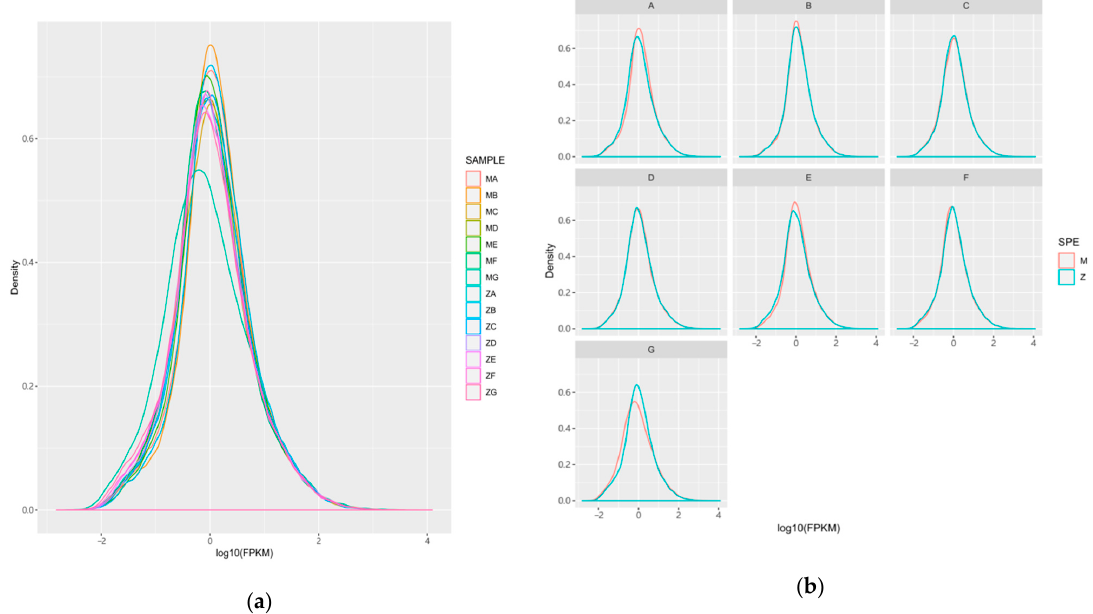
Figure 6. ( a ) General density distribution of P. massoniana and Z pine unigenes by FPKM analysis; ( b ) Pairwise comparison of general density distribution of same stage P. massoniana and Z pine unigenes by FPKM analysis, M: P. massoniana (red curve), Z: Z pine (green curve), A~G: the seven successive stages of pinecone development. X-axis: logarithm to base 10 of FPKM, y-axis: density of distribution.